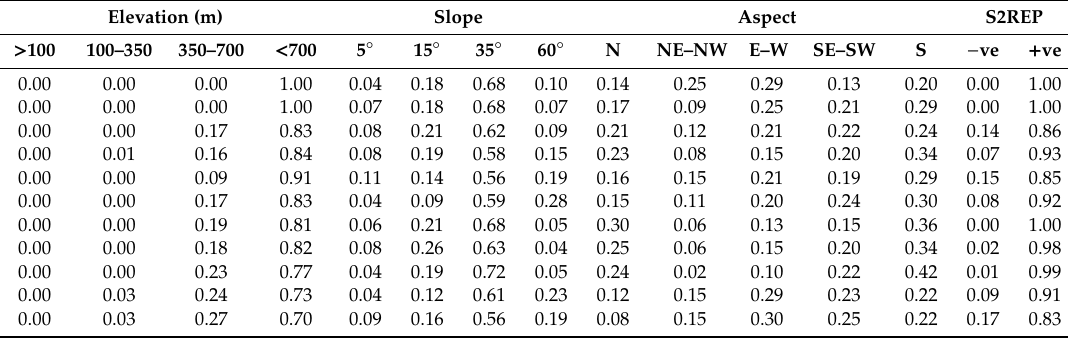
Table 2. Cross-tabulation of Digital Elevation Model (DEM) products and Sentinel-2 Red Edge Position Index